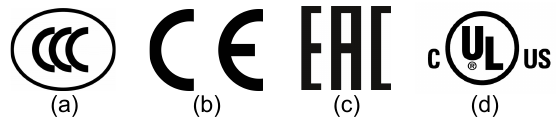
Figure 4. Certification marks for: ( a ) China; ( b ) European Union; ( c ) Eurasian Customs Union; ( d ) United States of America and